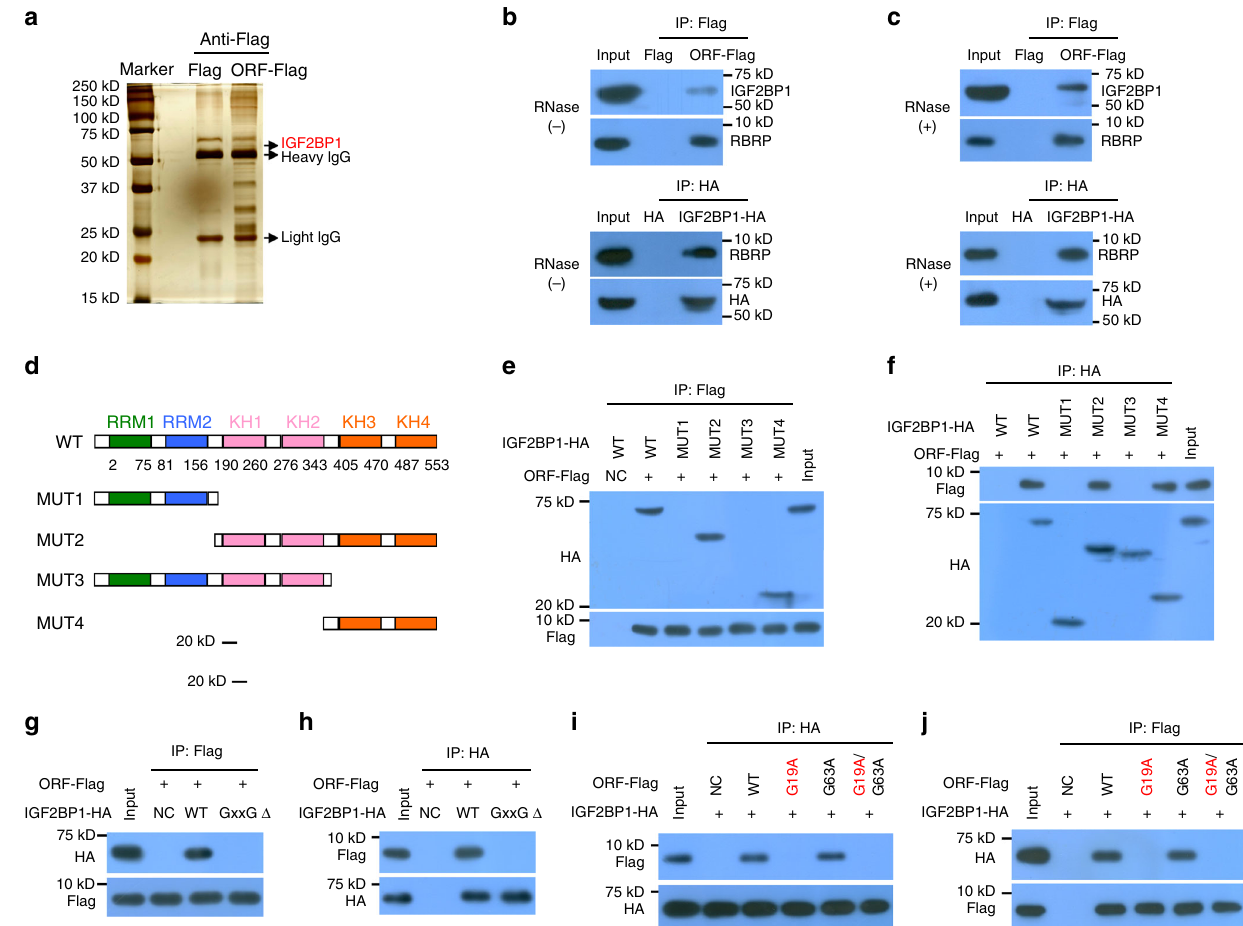
Fig. 4 RBRP interacts with the m 6 A reader IGF2BP1. a Proteins that interacted with RBRP were identi fi ed by co-IP together with mass spectrometry. b , c The LINC00266-1 ORF-Flag (upper panel) and IGF2BP1-HA (lower panel) vectors were transfected into HEK293T cells, RBRP-Flag and IGF2BP1-HA complexes were co-IPed with anti-Flag and anti-HA antibodies in the absence ( b ) or presence ( c ) of RNase A treatment, and IGF2BP1 and RBRP/HA were detected, respectively. d Diagram of the different domains of the WT and mutated- IGF2BP1 constructs. e , f The indicated IGF2BP1-HA mutants were cotransfected with the LINC00266-1 ORF-Flag vector into HEK293T cells; RBRP-Flag ( e ) and IGF2BP1-HA ( f ) complexes were co-IPed with anti-Flag and anti-HA antibodies, respectively. The IGF2BP1-HA mutant and RBRP-Flag complexes were detected using anti-HA and anti-Flag antibodies, respectively. g , h The WT and GxxG Δ -mutated IGF2BP1-HA vectors were transfected into HEK293T cells and the interactions of RBRP with the IGF2BP1 GxxG Δ mutant were determined. i , j The WT or mutated RBRP-Flag constructs were cotransfected with the IGF2BP1-HA plasmid into HEK293T cells, and the interactions of the RBRP mutants with IGF2BP1 were determined. Source data are provided as a Source Data fi